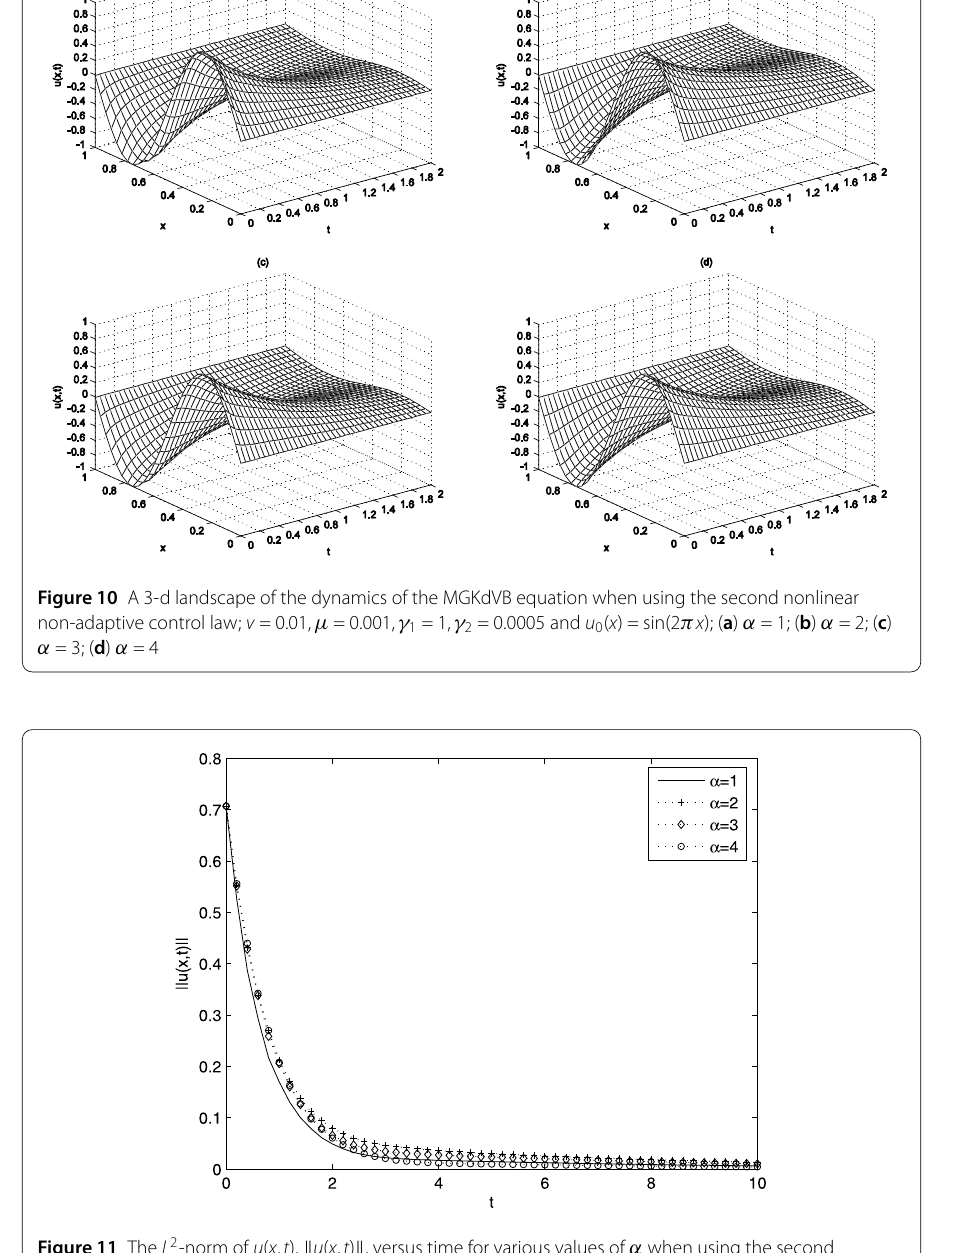
Figure 11 The L 2 -norm of u ( x , t ), (cid:7) u ( x , t ) (cid:7) , versus time for various values of α when using the second nonlinear non-adaptive control law; v = 0.01, μ = 0.001, γ 1 , γ 2 = 0.0005 and u 0 ( x ) = sin(2 π x